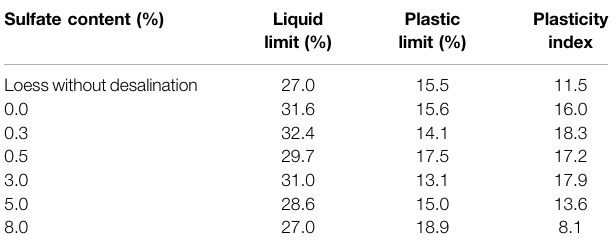
TABLE 6 | Atterberg limits graph of all samples.